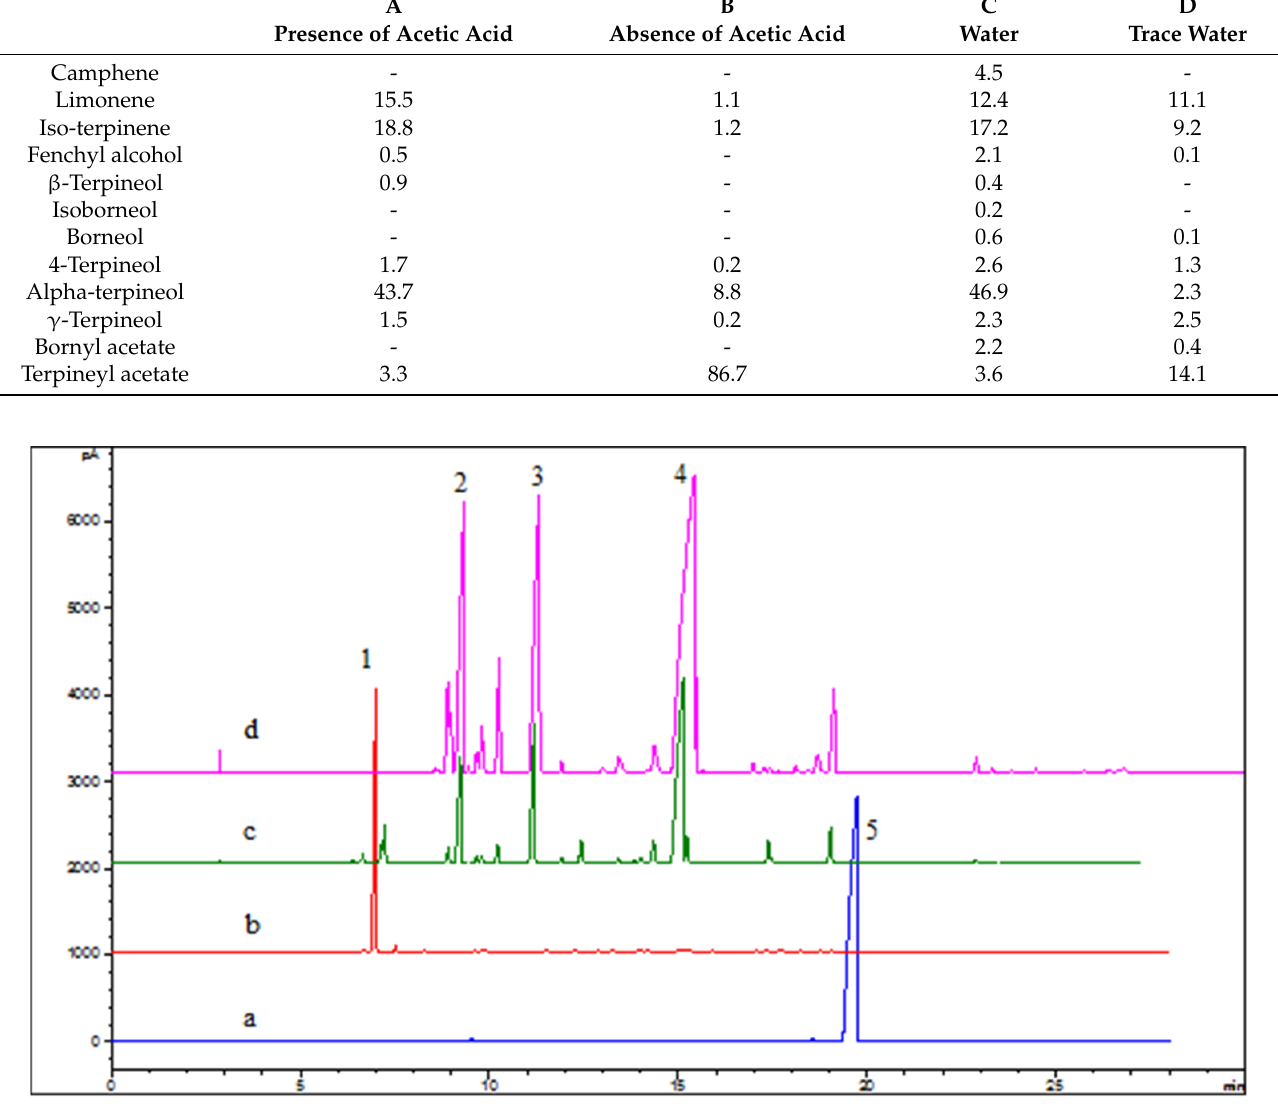
Figure 12. Gas chromatogram of raw materials and products, a . terpinyl acetate; b . alpha-pinene; c . hydration products of alpha-pinene; d . terpinyl acetate hydrolysate. Note: 1 . alpha-pinene; 2 . limo- nene; 3 . iso-terpinene; 4 . alpha-terpineol; 5 . terpinyl acetate.